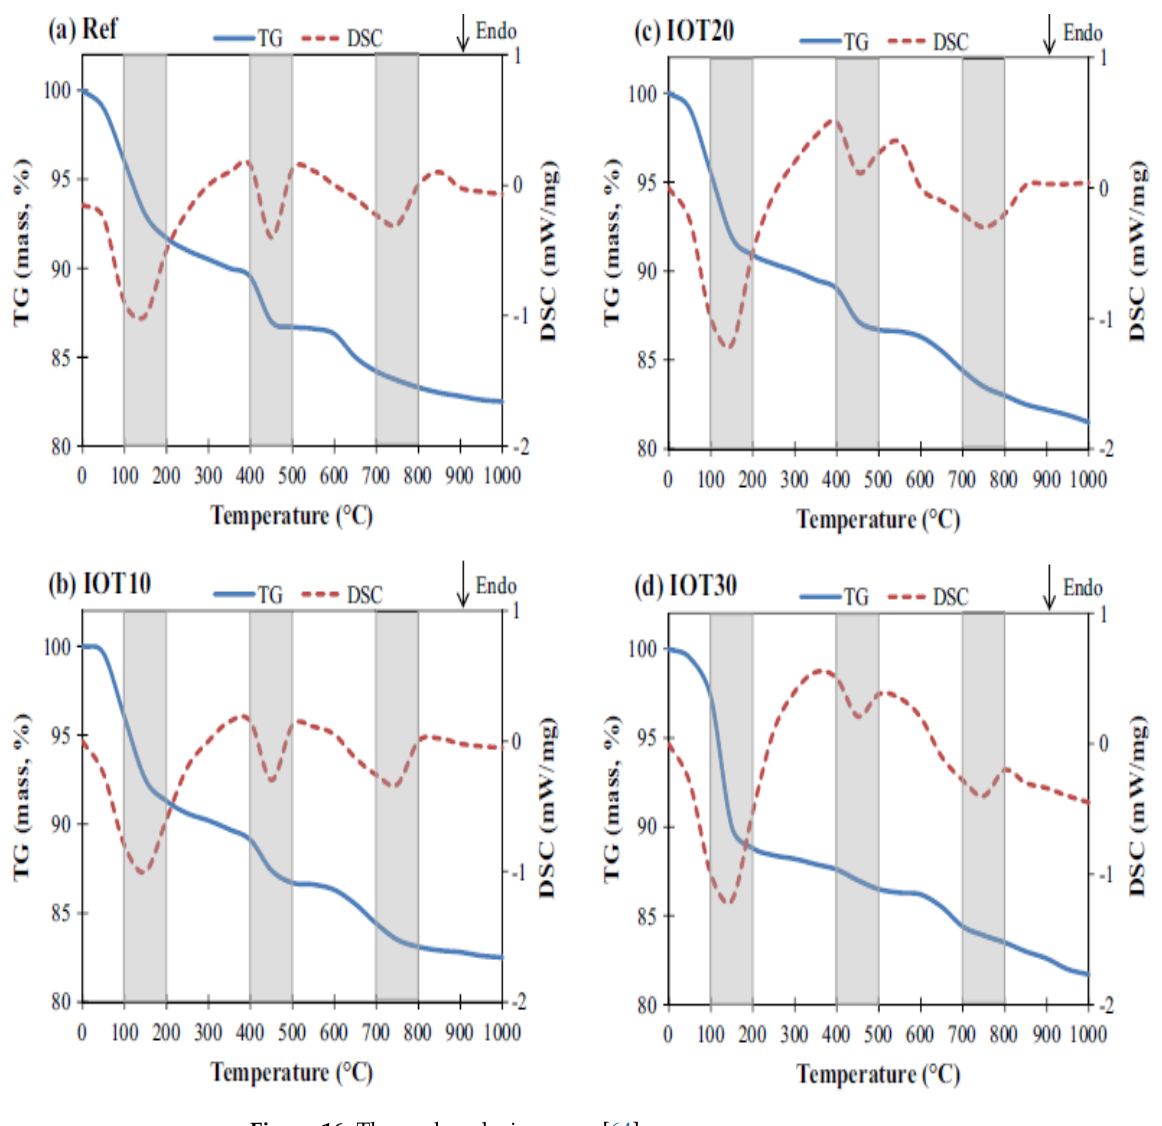
Figure 16. Thermal analysis curves